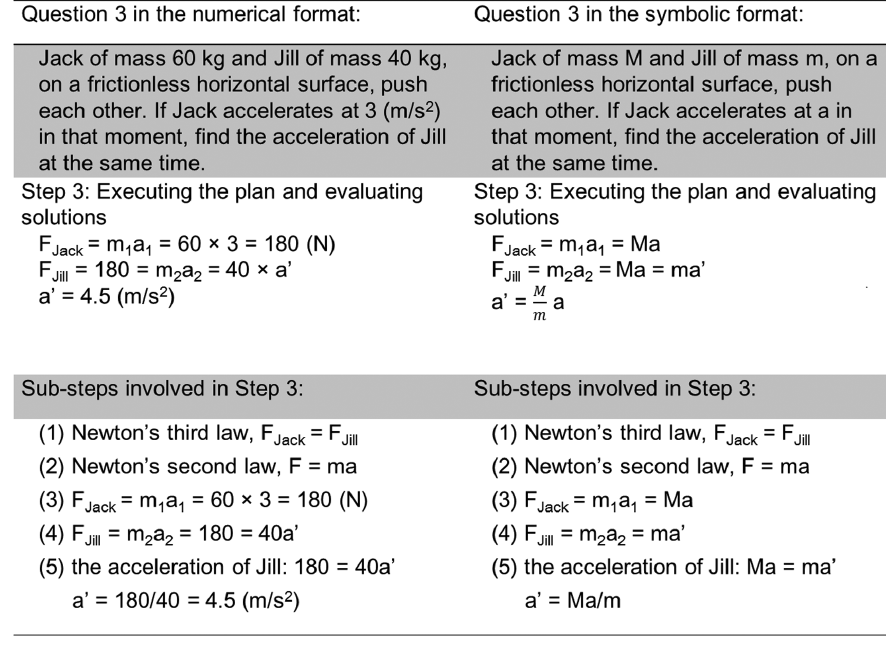
FIG. 1. Elements in step 3 of question